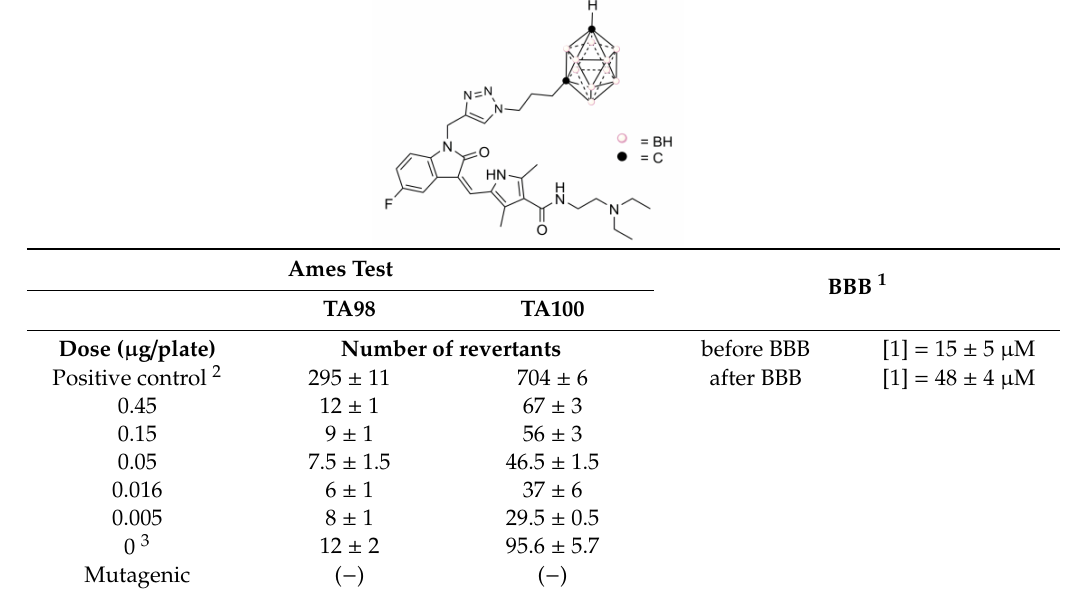
Table 4. Summary of Ames and BBB permeability tests for compound 1